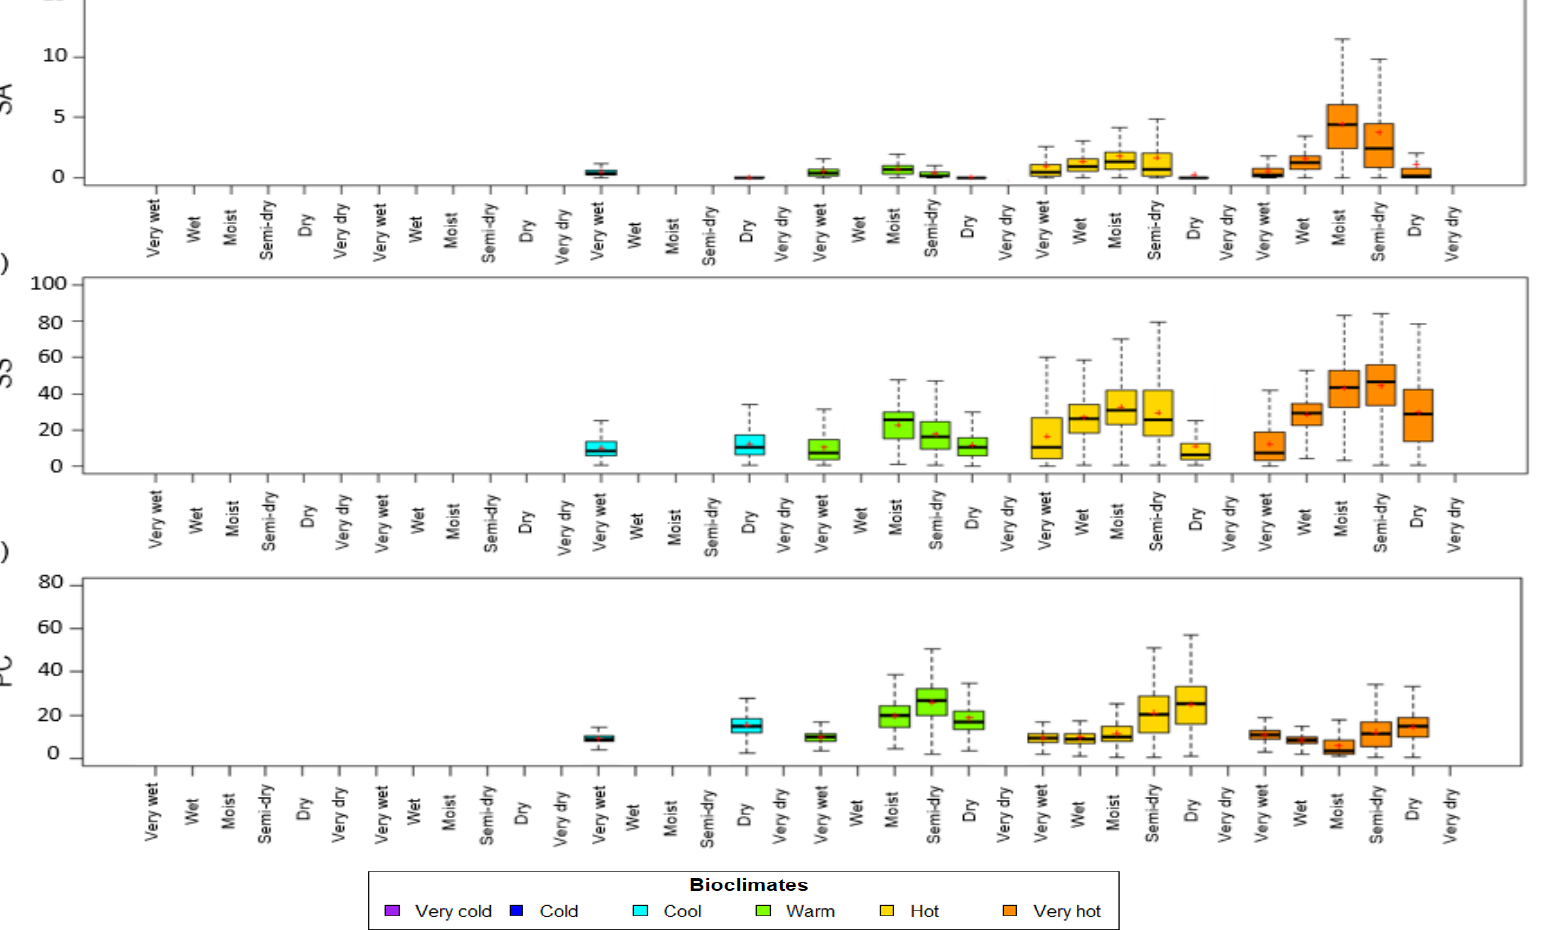
Figure 5. ( a ) Boxplots of the seasonality amplitude, ( b ) seasonality stability ( c ) and the pluri-annual cycles indicator of ecosystems with bimodal seasonal pattern per each bioclimate.